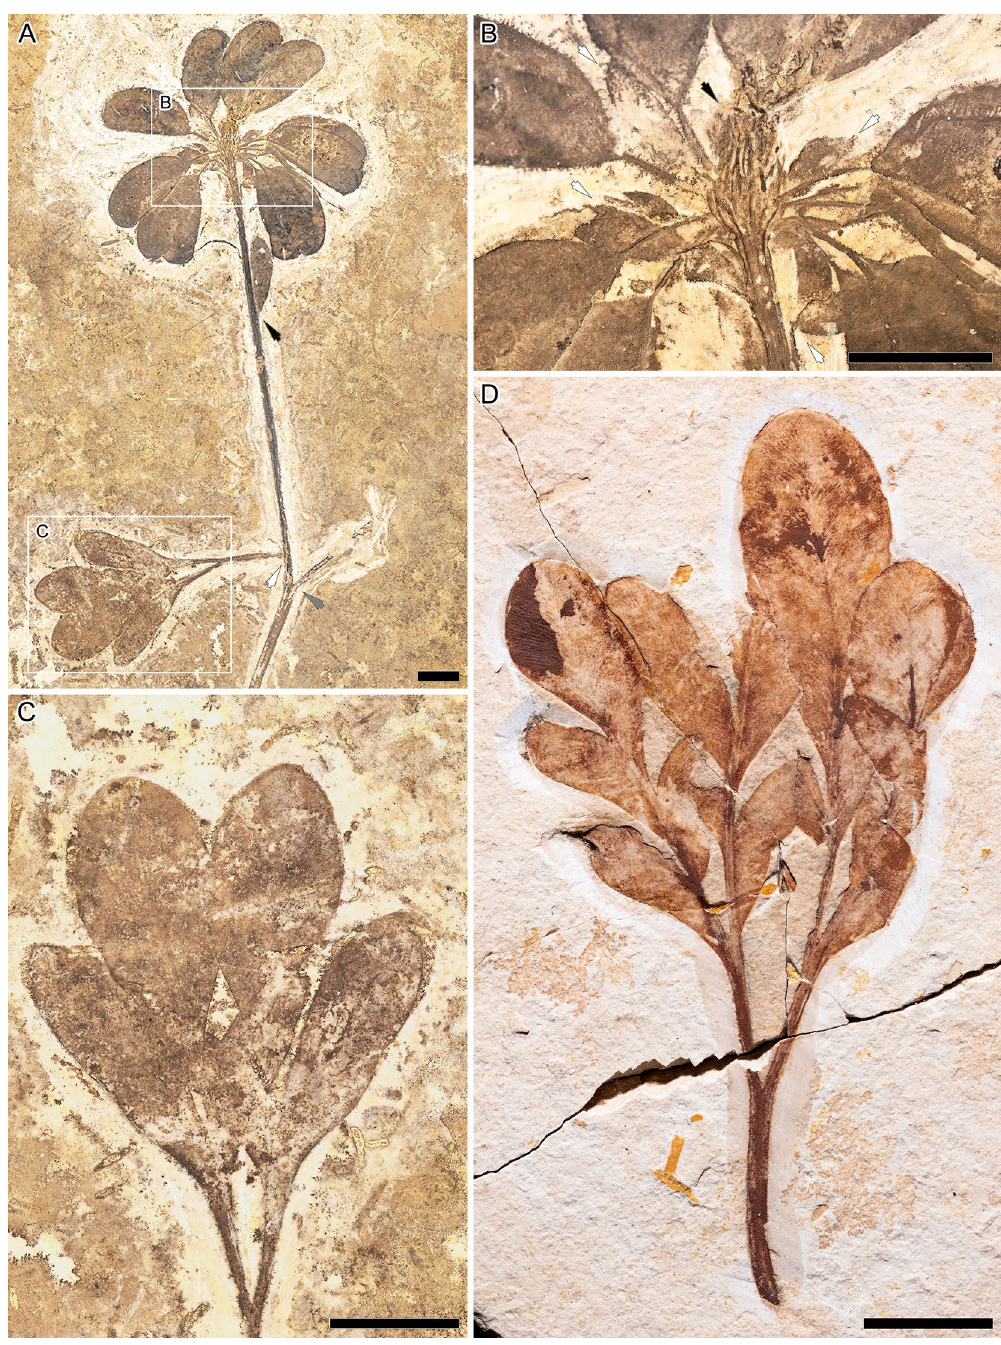
Figure 2. Santaniella lobata gen. nov. et sp. nov. ( A – C ) paratype (MB. Pb. 1997/1347). ( A ) general view of paratype showing leaves and a terminal aggregate fruit with 10–11 stipitate follicles (black arrow points to leaf attachment of the distalmost leaf, white arrow to leaf attachment of the basalmost leaf, and gray arrow to a putative sub-opposite leaf); ( B ) close-up on follicles surrounded by 4 outer (white arrows) and several innermost erect and more or less laciniate (black arrow) persistent perianth-like organs; ( C ) close-up on leaf type II with two trilobed leaflets; ( D ) leaf type III (paratype: LP UFC CRT 1559a). Scale bars: 1